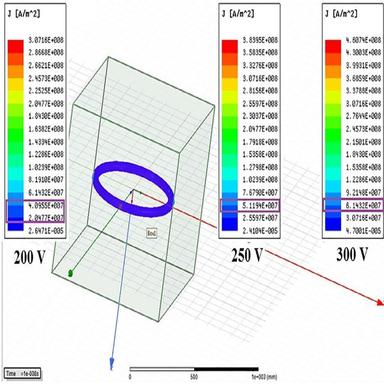
Current density values after ANSYS simulation.